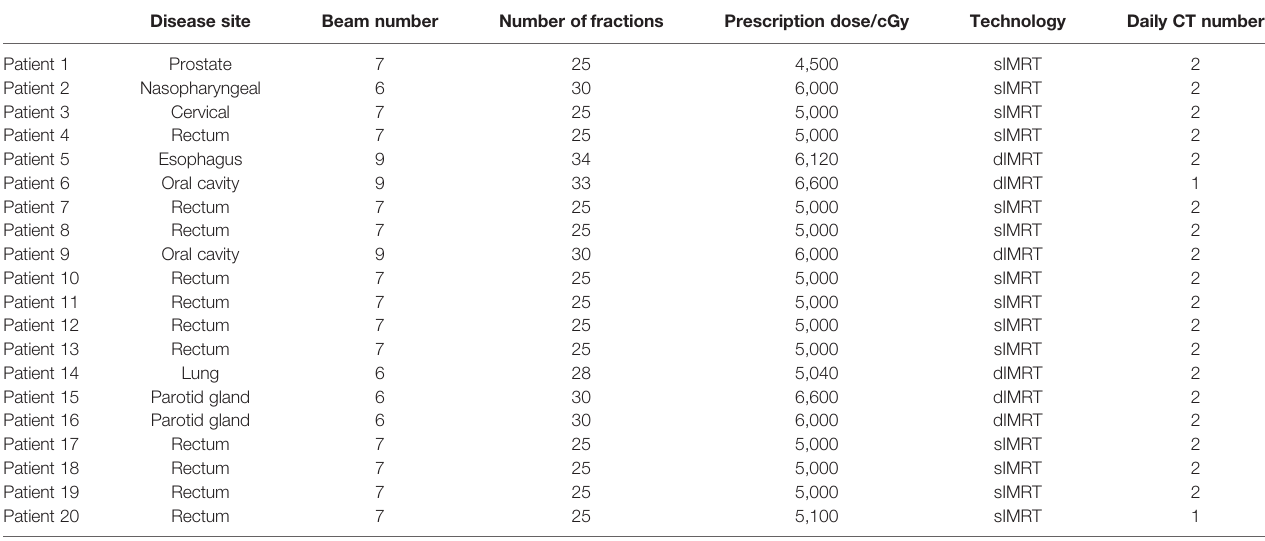
TABLE 1 | Patient cohort